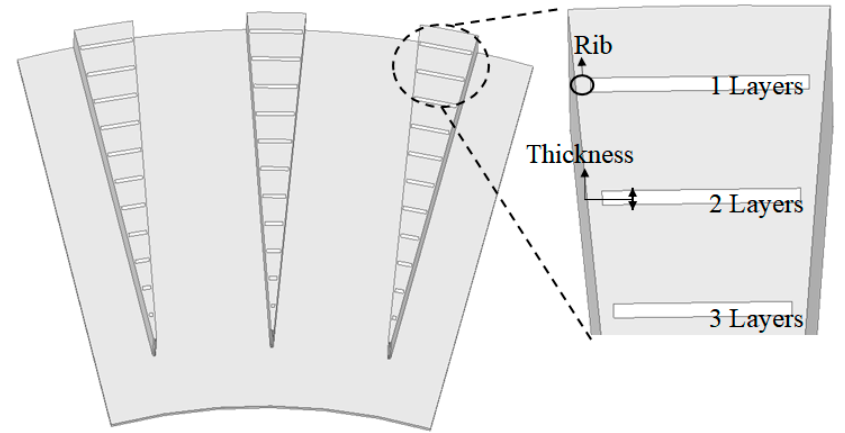
Figure 5. Parameters for optimization of the proposed model [16].